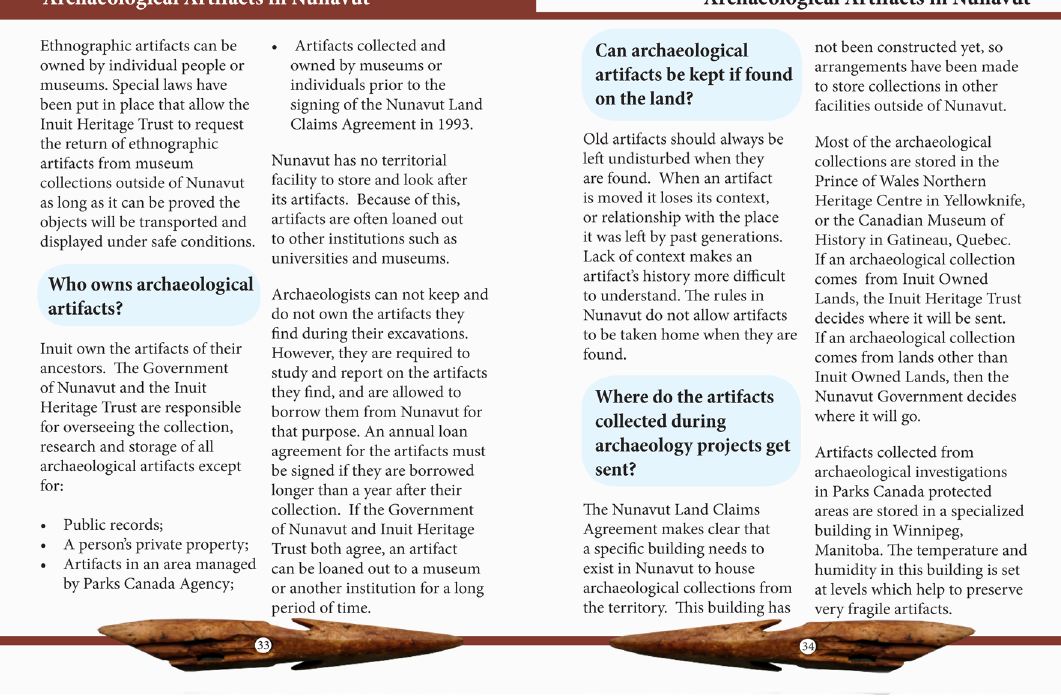
Figure 3: A page spread from the Guide to Nunavut Archaeology and Artifacts for Northern Communities